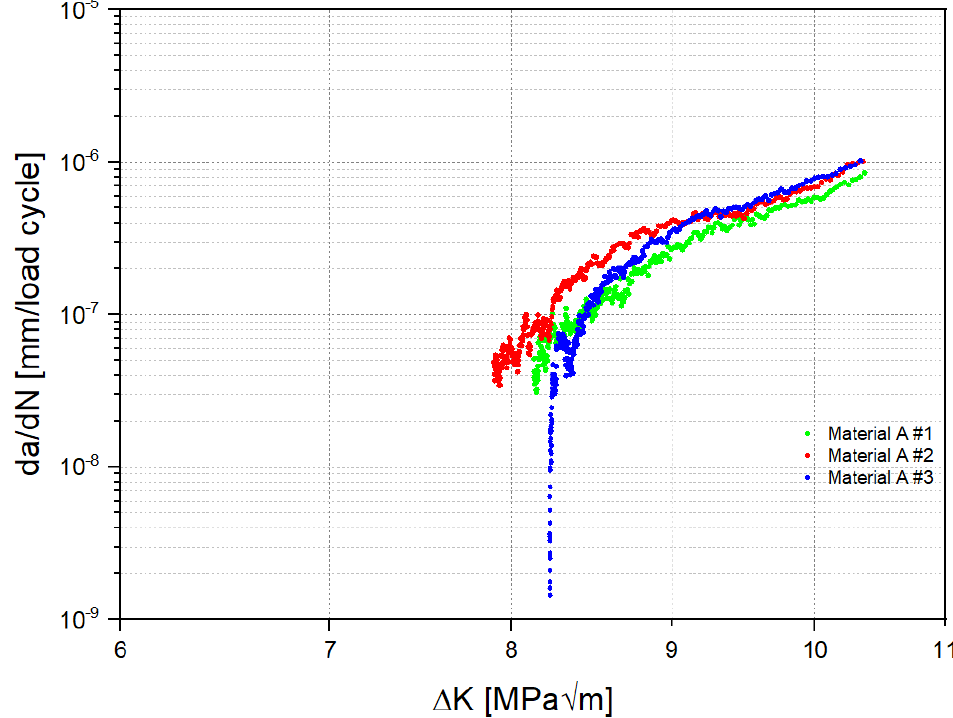
Figure 2. Fatigue crack growth curves for Material A; ECD: 11.83 mm; ALA: 36.20 mm; UTS: 1432 √ m—not MPa; K IC : 128 MPa √ m—not valid. 1432 MPa; K IC : 128 MPa